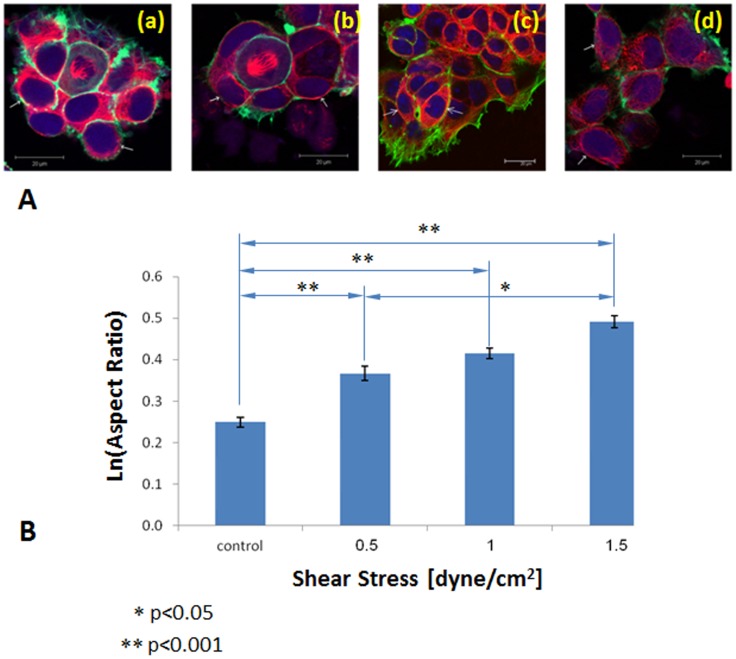
(A) Elongation of the cells, defined by the aspect ratio of the ellipsoid diameters.The arrows are pointing at representing cells. (a) Control culture, (b) 0.5 dyne/cm2 culture, (c) 1.0 dyne/cm2 culture, and (d) 1.5 dyne/cm2 cultures. (B) Variation of the logarithmic value of the aspect ratio that define the level of cell elongation with the level of the applied shear stress (±standard deviation).